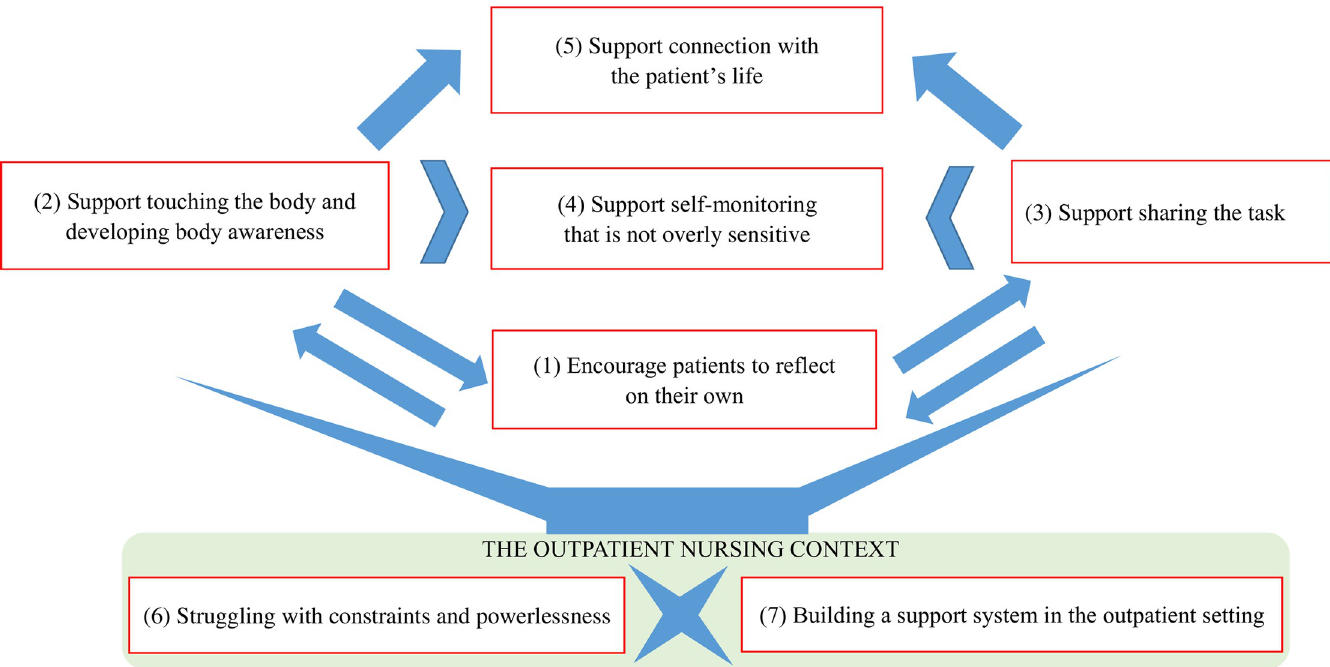
Fig 1. Support and the outpatient care context, for self-monitoring in patients with chronic heart failure. Note: The arrows indicate the direction of influence. The chevrons indicate situational influences. The cross indicates conflict.